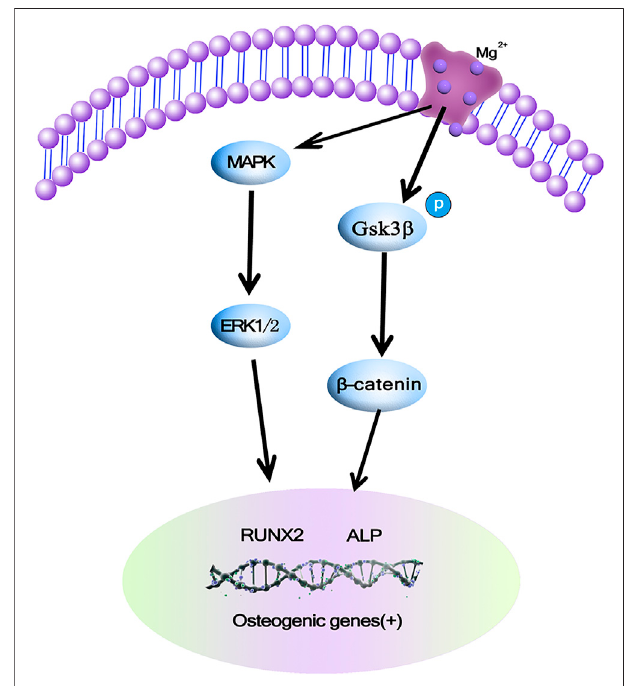
FIGURE 3 | Mg 2+ , Ca 2+ and Sr 2+ could promote osteogenic gene expression via bindingtocalcium-sensingreceptor(CaSR)andactivatingERK signaling pathway through Ras/Raf/MEK/ERK pathway (Li et al., 2016).